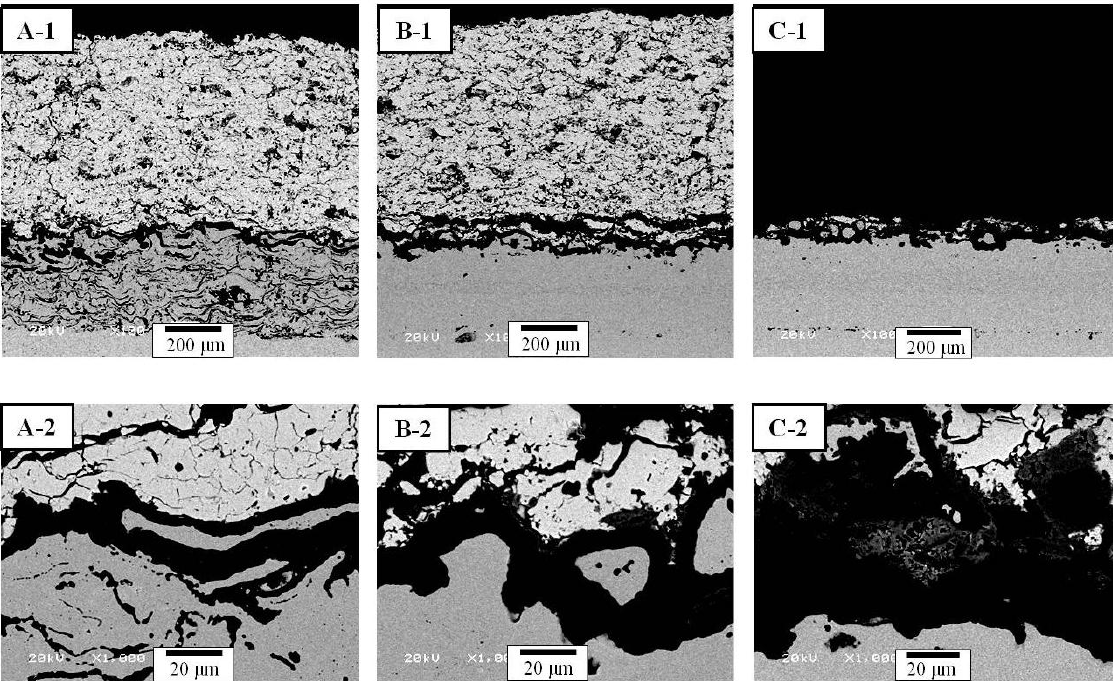
Figure 4. Cross-sectional microstructures of TBCs after CFTF tests: ( A ) TBC with APS bond coat; ( B ) TBC with HVOF bond coat; and ( C ) TBC with LPPS bond coat. Each number indicates the overall and interface microstructures,